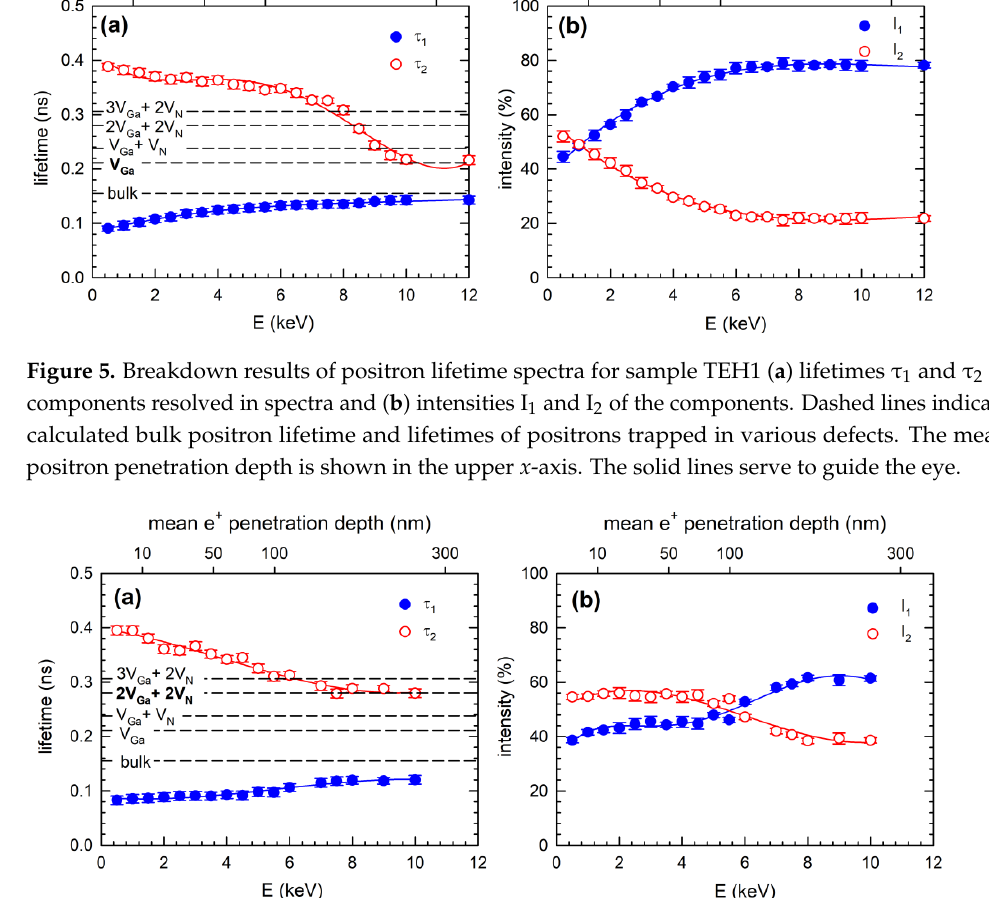
Figure 7. ( a ) The development of the lifetime τ 2 measured for the energy of incident positrons of 12 keV on different film deposition temperatures; ( b ) the concentration of V Ga determined by VEPAS for samples prepared with growth parameters defined in Table 1. Labels indicate notation of sample and dominant type of defects in the sample. Solid lines are plotted to guide eyes only.